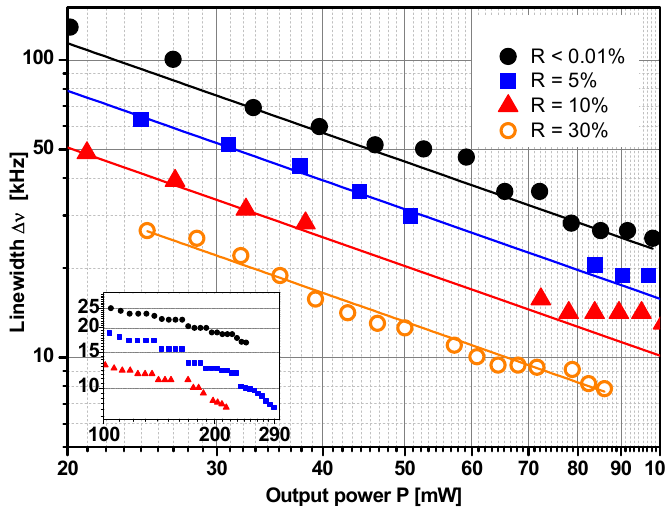
Figure 4. Dependence of the intrinsic linewidth on the output power for the DFB diode lasers with various front facet reflections: R < 0.01% (black solid circle), R = 5% (blue solid square), R = 10% (red solid triangle), and R = 30% (orange open circle). The solid lines show the result of fitting a 1/P dependence to the data. Inset: Linewidth vs. output power in the high power regime.